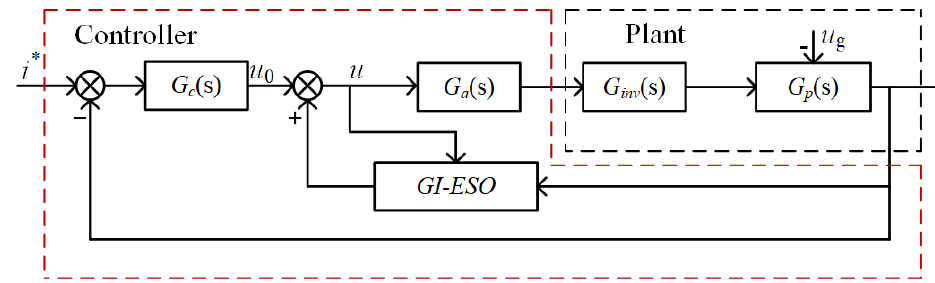
Figure 5. Block diagram of the proposed control method